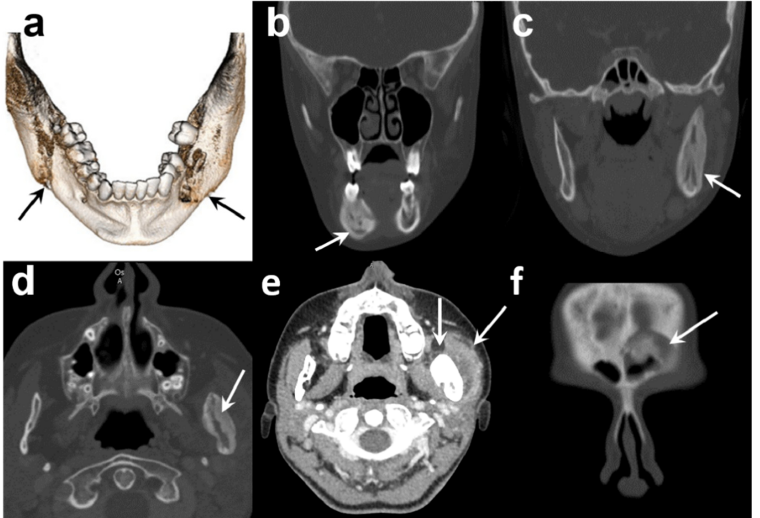
Figure 2. Diagnostic CT scan of the patient: ( a ) 3D reconstruction of mandible, ( b ) coronal bone- window section of sclerosis and osteolytic in right corpus of the mandible, ( c , d ) coronal and axial bone window showing an enlargement of left ascending ramus with osteosclerosis with few areas of osteolysis, ( e ) axial section in soft tissue window revealing a swelling of the left masseter muscle, ( f ) coronal bone-window section showing an irregular area of sclerosis involving the edge of the left frontal sinus.